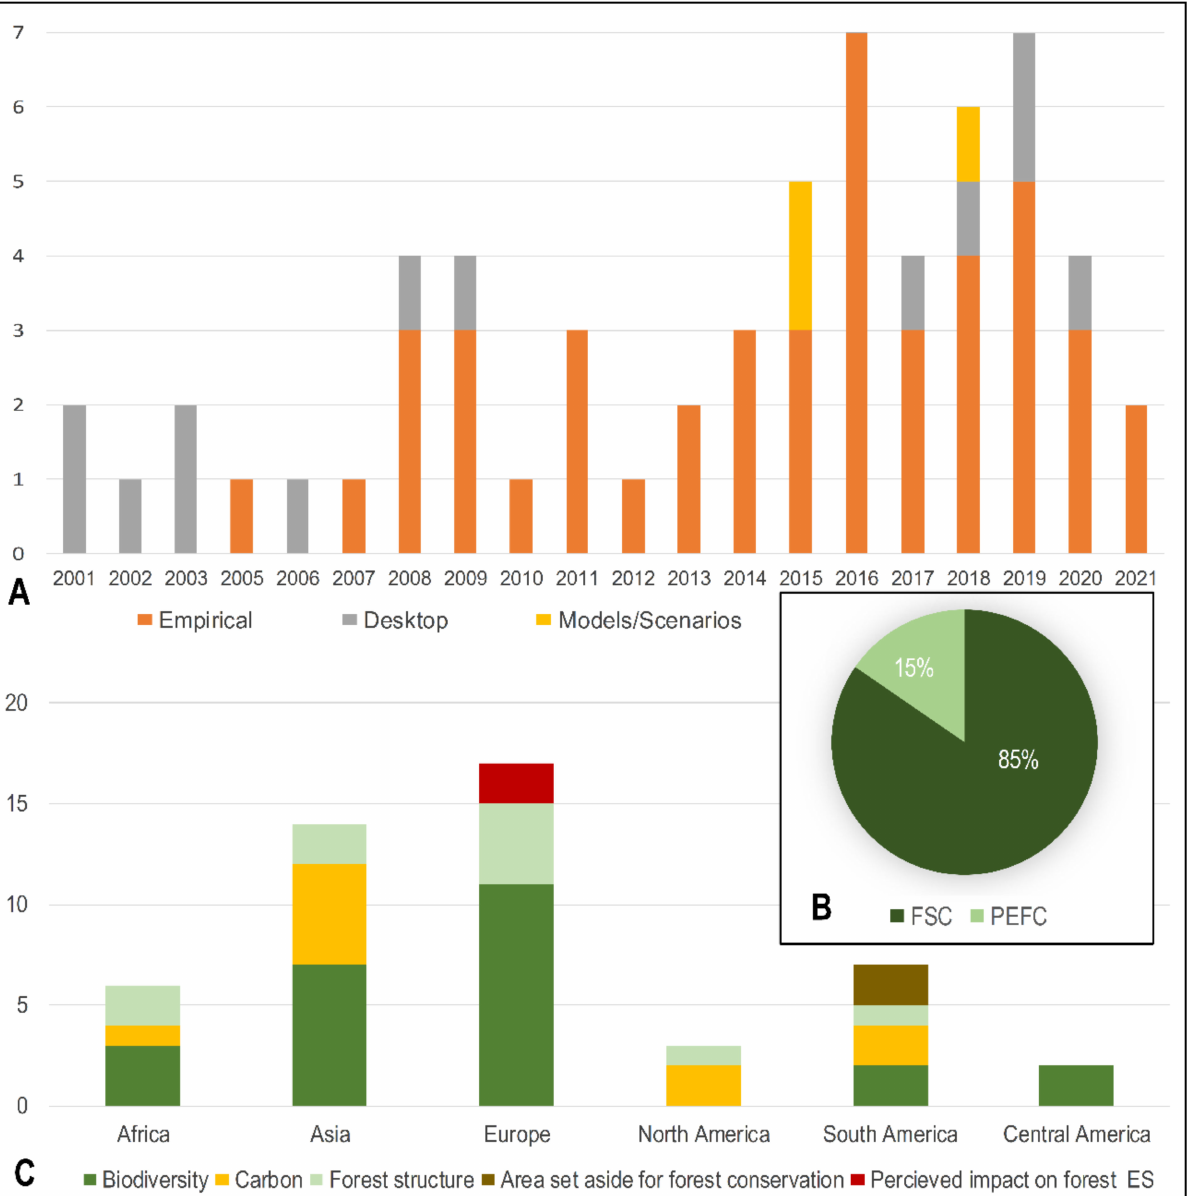
Figure 5. Number of publications on forest degradation presented by year of publication and publication type ( A ). Share of certification scheme studied in the case studies ( B ). Distribution of empirical case studies, presented per world region and indicator (is not equal to the number of publications) ( C